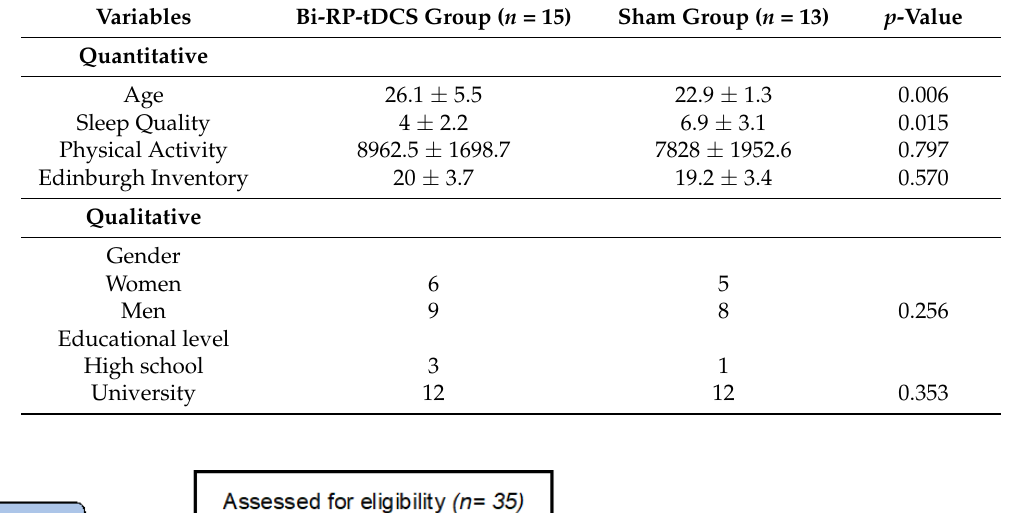
Table 1. Descriptive analysis of sociodemographic data. To evaluate the homogeneity of the different variables between groups. Independent Student’s t-test was used for quantitative variables (mean ± standard deviation) and Pearson’s chi 2 for categorical variables (number of subjects and percentage).